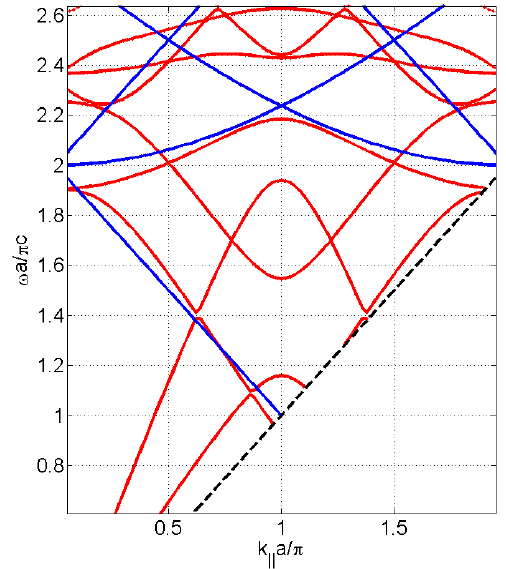
Figure 6. Calculated dispersion diagram (red lines) and Wood minima (blue lines), as a function of the parallel wavevector k ‖ · a / π in the Γ X direction and the normalized frequency ω a / π c, for the square distribution of circular holes having diameter, d , of 1 mm and a unit cell period, a , of 3 mm. By superimposing the dispersion diagram with the graphics of the transmitted sound power coefficient as a function of the parallel wavevector for the perforated plates with water or air-filled holes (see Figure 7), it is observed that while some lines of the dispersion diagram clearly indicate a significant increase in transmission through plate, others do not exhibit.